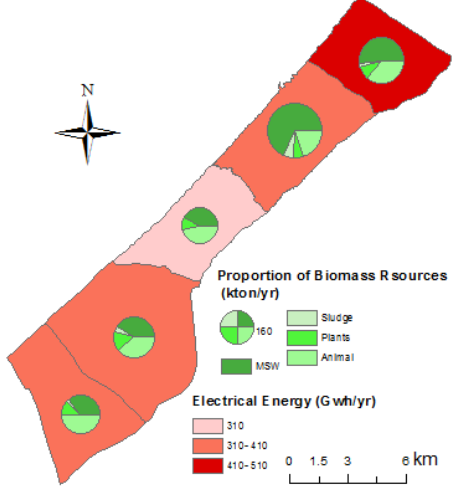
Figure 8. The electrical energy (GWh/year) generated in the GS from methane and the biomass forms proportions.